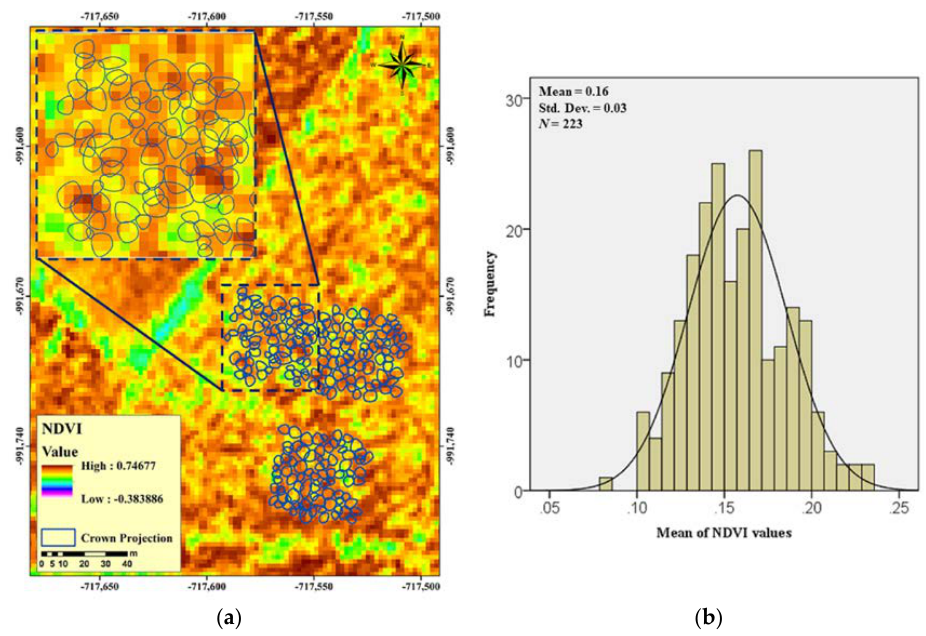
Figure 4. ( a ) The NDVI (normalized difference vegetation index) calculated for the study area and ( b ) the histogram of NDVI derived from Pléiades 1A satellite imagery.